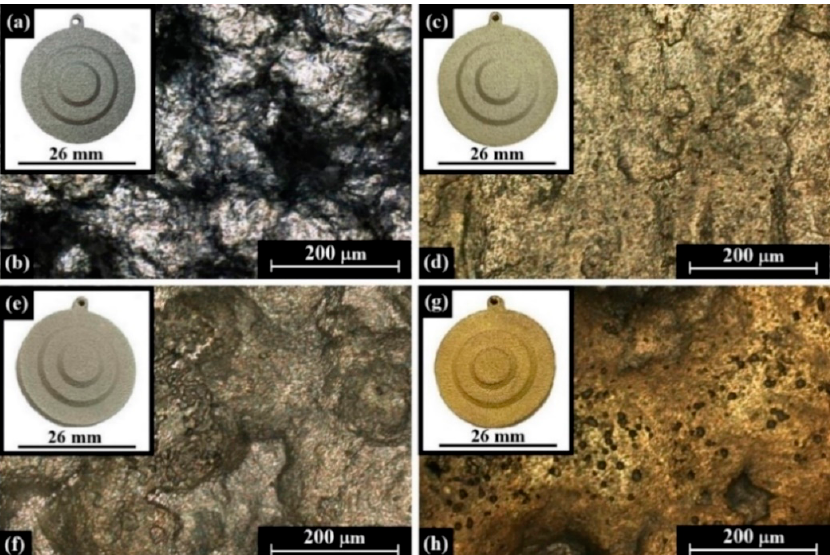
Figure 13. Optical images of the AM-LPBF AlSi10Mg disk-shaped specimens’ surface: ( a , b ) as- printed sample; ( c , d ) covered with electroless electrum layer, produced with 1:1 Ag/Au molar ratio of solution at 80 °C; ( e , f ) covered with electroless electrum layer, produced with 1:2 Ag/Au molar ratio of solution at 80 °C; and ( g , h ) covered with electroless electrum layer, produced with 1:2 Ag/Au molar ratio of solution at 90 °C.